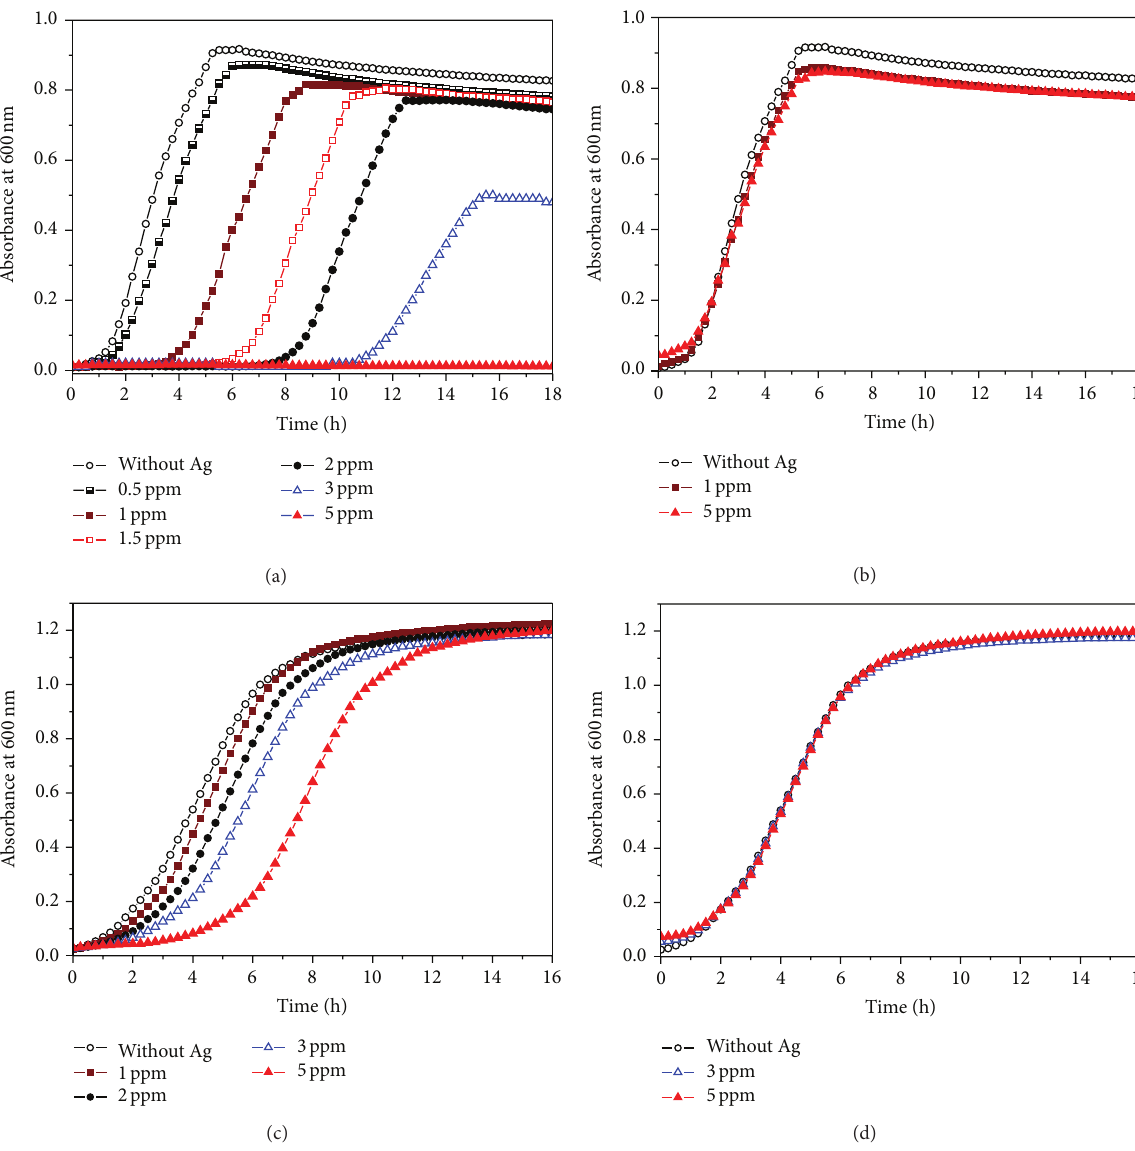
Figure 4: Growth curves of E. coli (ATCC 25922) at different Ag NPs concentrations. The mean diameter of Ag NPs is (a) 3nm and (b) 20 nm. Growth curves of vancomycin-intermediate resistant S. aureus (ATCC 700699) in the absence and presence of Ag NPs are shown in